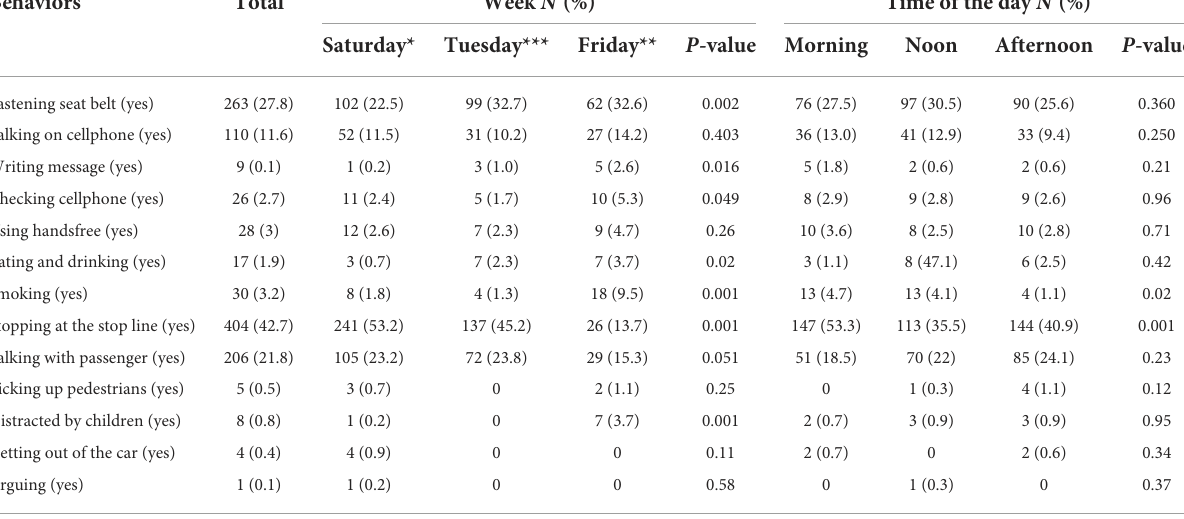
TABLE 3 Behaviors of drivers at traffic lights based on day of the week and time of day (N = 946). Behaviors Total Week N (%) Time of the day N (%)